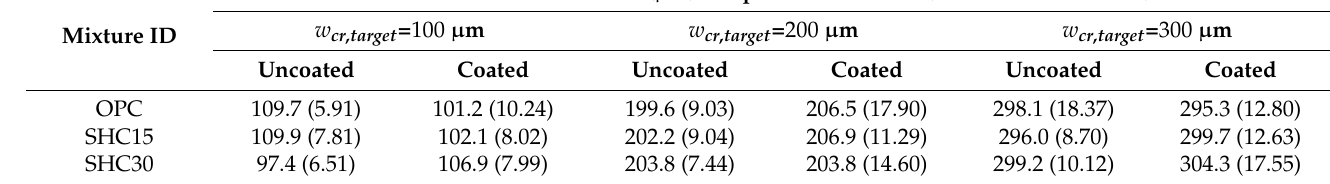
Table 2. Measured crack